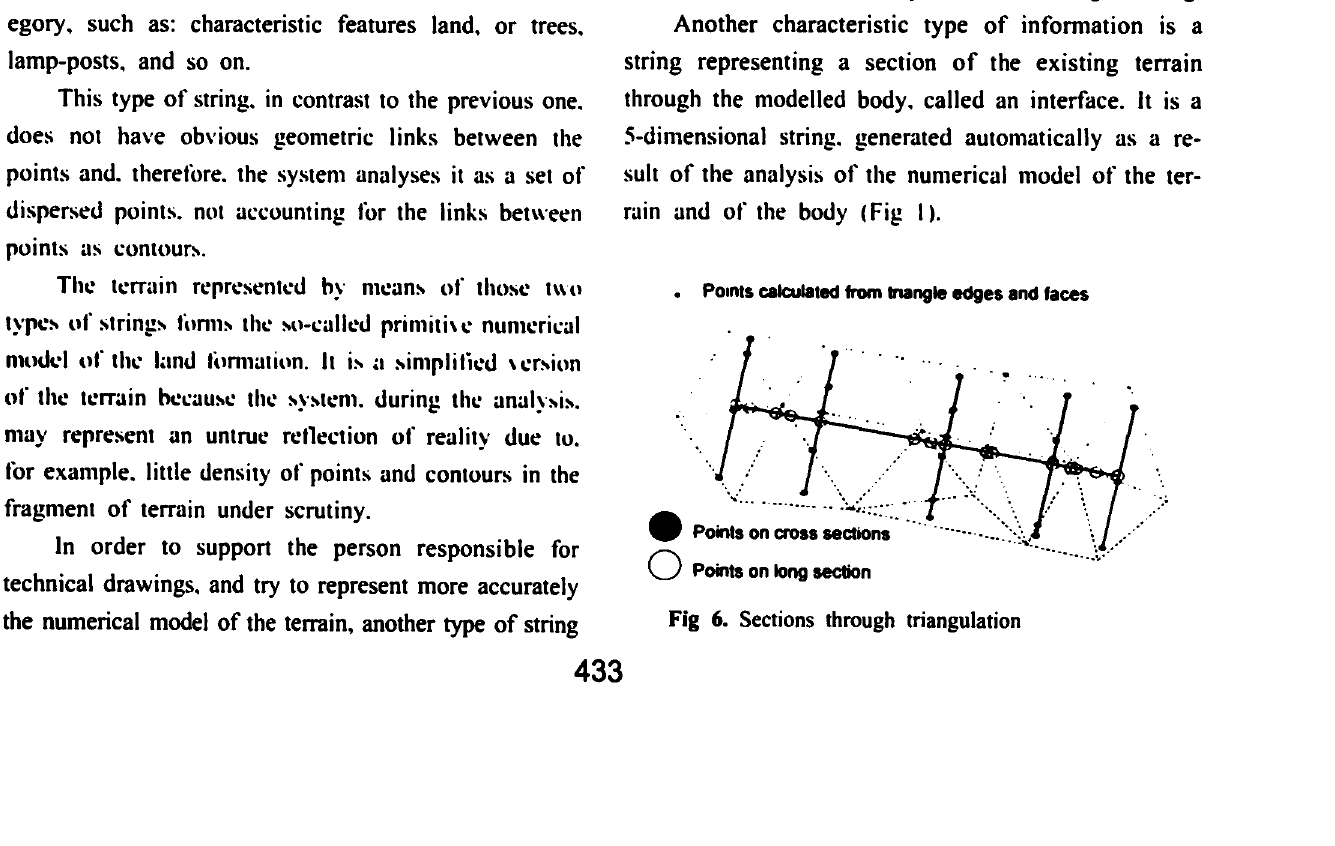
Fig S. A model of the road body under design together with the terrain model The string in such a shape has 36 dimensions and represents a model of triangulation of the terrain, ie the representation of the terrain by means of triangular planes of the same inclination.